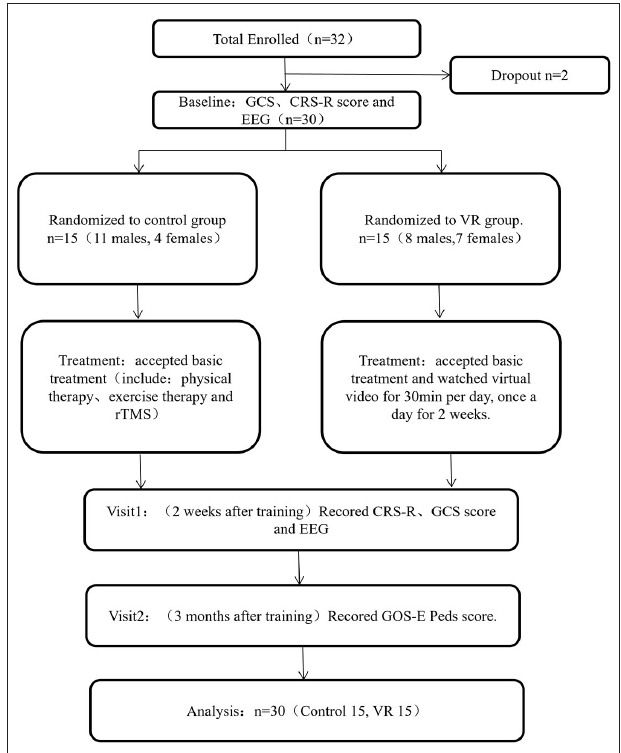
FIGURE 1 | Diagram describing study flow. GCS, Glasgow Coma Scale; CRS-R, Coma Recovery Scale-Revised; EEG, electroencephalogram; TMS, transcranial magnetic stimulation; VR, virtual reality; GOS-E Peds, Glasgow Outcome Scale Extended Pediatric